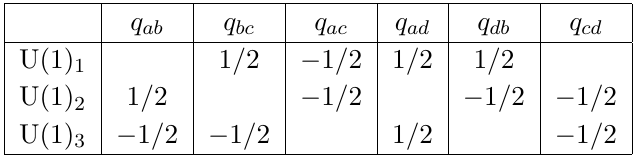
Table 1 . The (cid:13)avor charges of the hypermultiplet scalars in the 3d